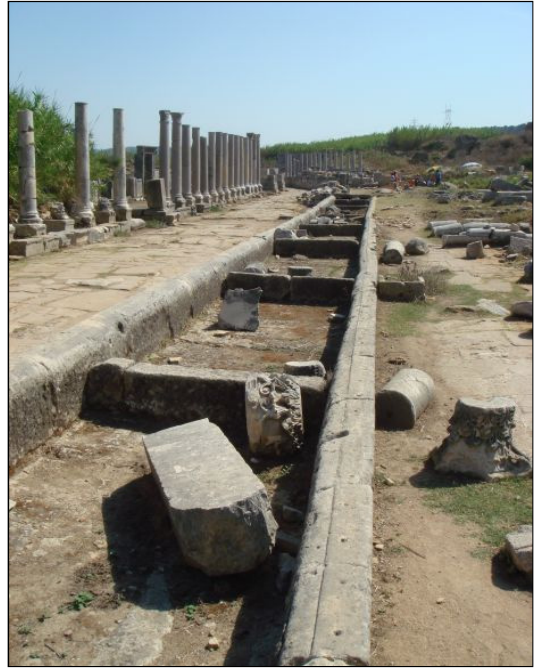
Figure 13. Aqueduct channel in the middle of the main colonnaded street in